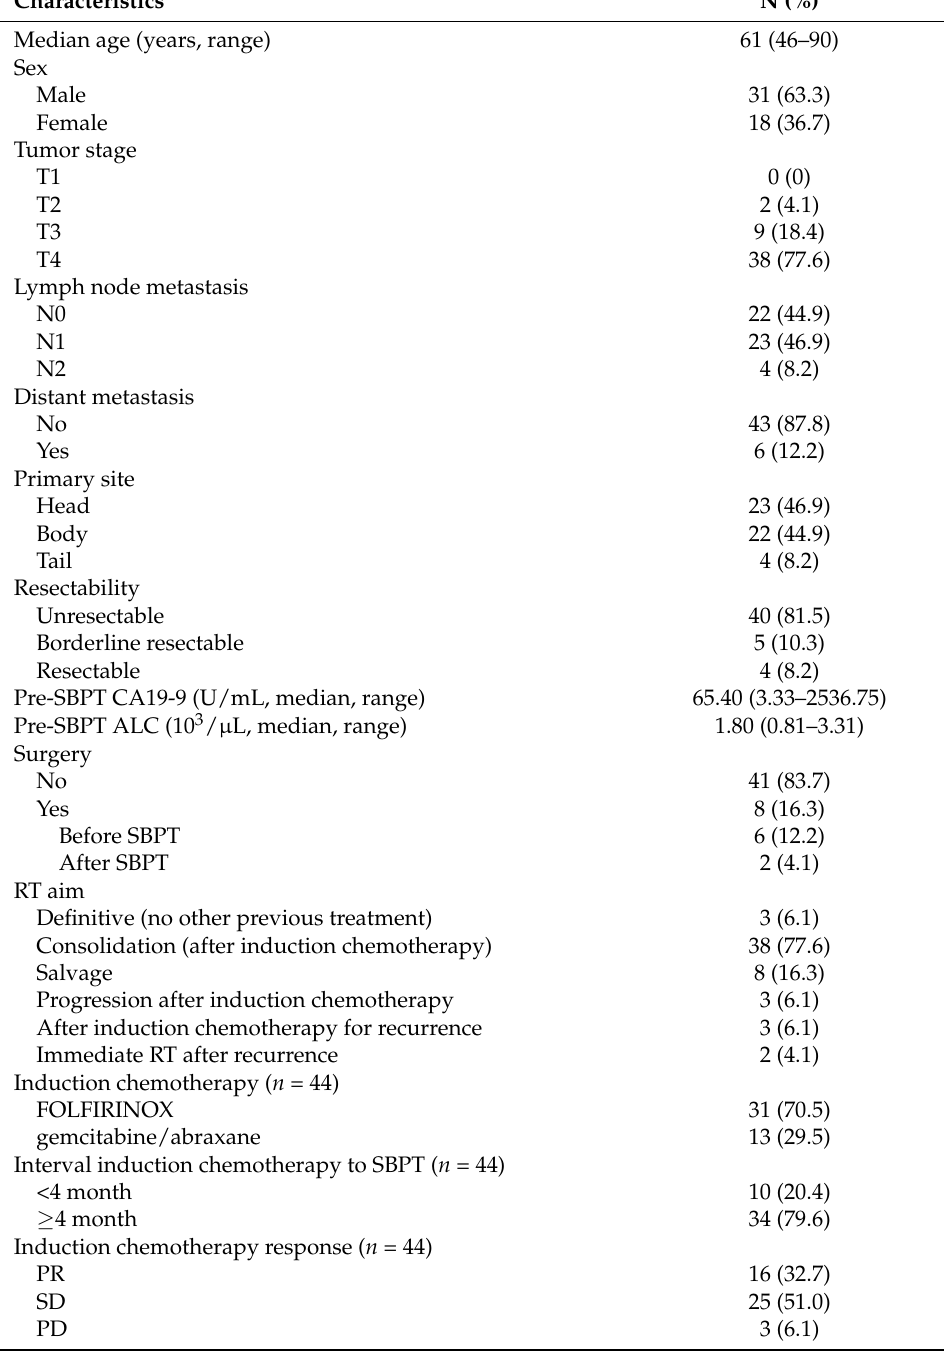
Table 1. Characteristics of patients ( n =